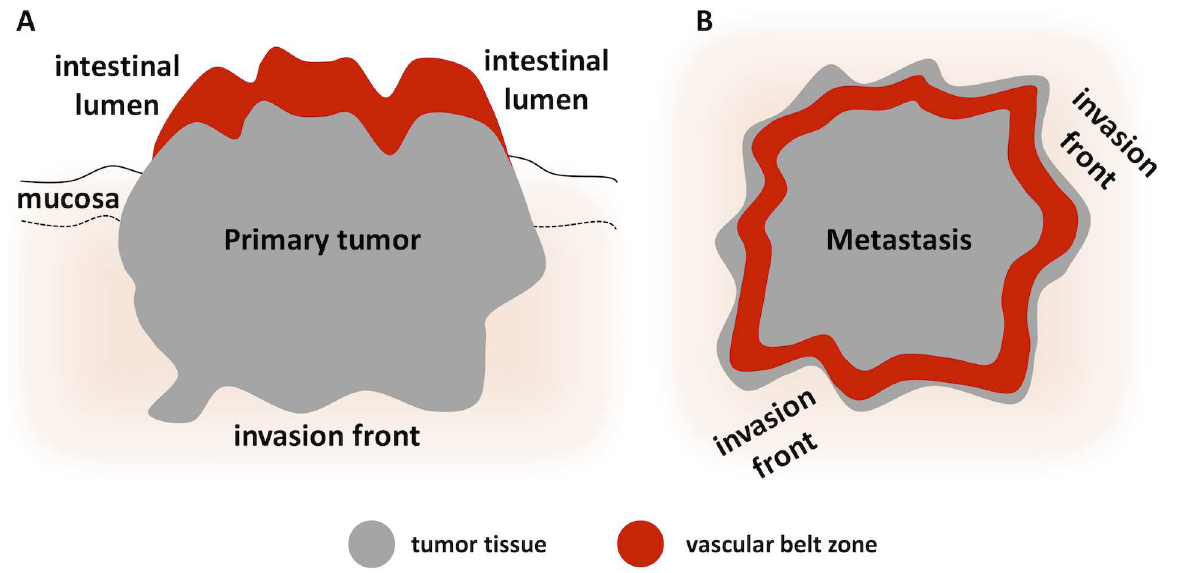
Fig 7. Graphical summaryof the model. (A-B) Based on experimental data, we proposea new model for angiogenesisthat is schematically shown in A for primary tumors and B for metastasis. The model states that blood vessels are preferentially locatedclose to the intestinallumen in primary tumors and close to the invasionfront in liver